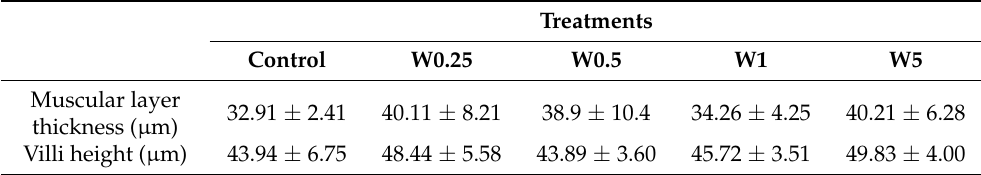
Table 3. Intestinal histology of Litopenaeus vannamei reared in the water supplemented with Micro-Aid Liquid 10 once per week at the levels of 0 (control), and 0.25 mL m 3 − 1 (W0.25), 0.5 mL m 3 − 1 (W0.5),